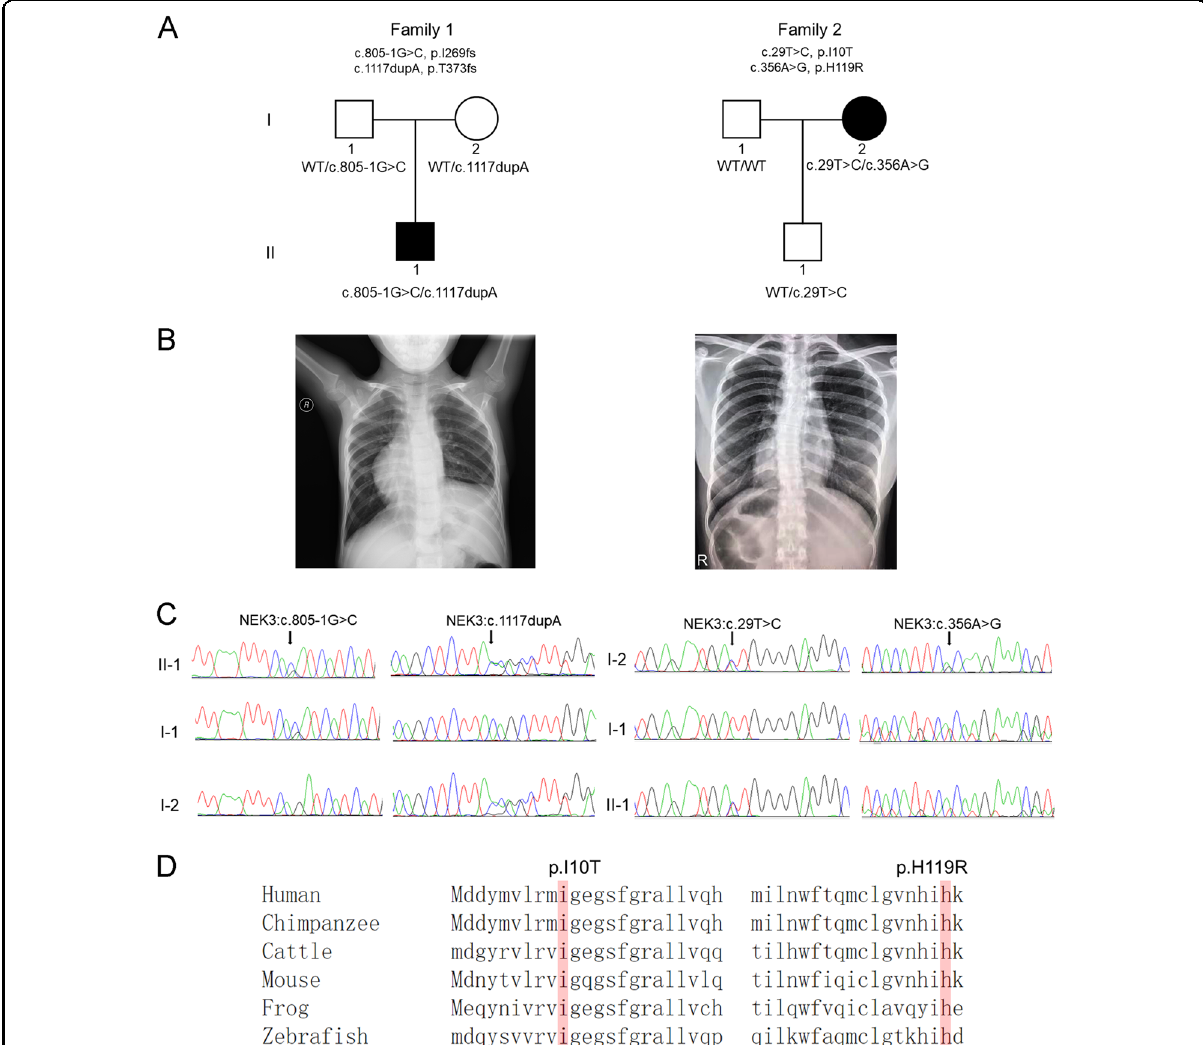
Fig. 1 Biallelic NEK3 mutations in two unrelated patients with abnormal LR patterning. a Pedigree of Family-1 and -2 indicating the affected individuals and the segregation of NEK3 recessive variants. b Chest X-ray shows isolated dextrocardia and raised diaphragm on the left side in the Patient-1 (left), and the mirror-image arrangement of the abdominal organs and mild scoliosis in the Patient-2 (right). c Sanger segregation of NEK3 variants (c.805-1G>C/c.1117dupA; c.29T>C/c.356A>G) in the patients and unaffected individuals as indicated. d Sequencing alignment of missense variants p.I10T (c.29T>C) and p.H119R (c.356A>G) in different species including zebra fi sh ( Danio rerio ) and tropical clawed frog ( Xenopus tropicalis